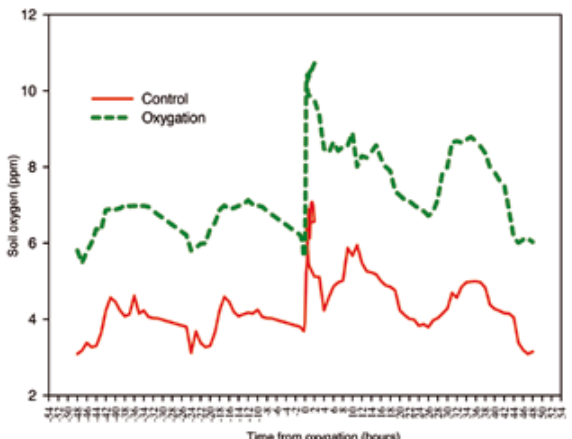
Table 1 - Soil physical and biological properties assessed at the end of the ratoon crop for oxygation, control and no-irrigation treatments